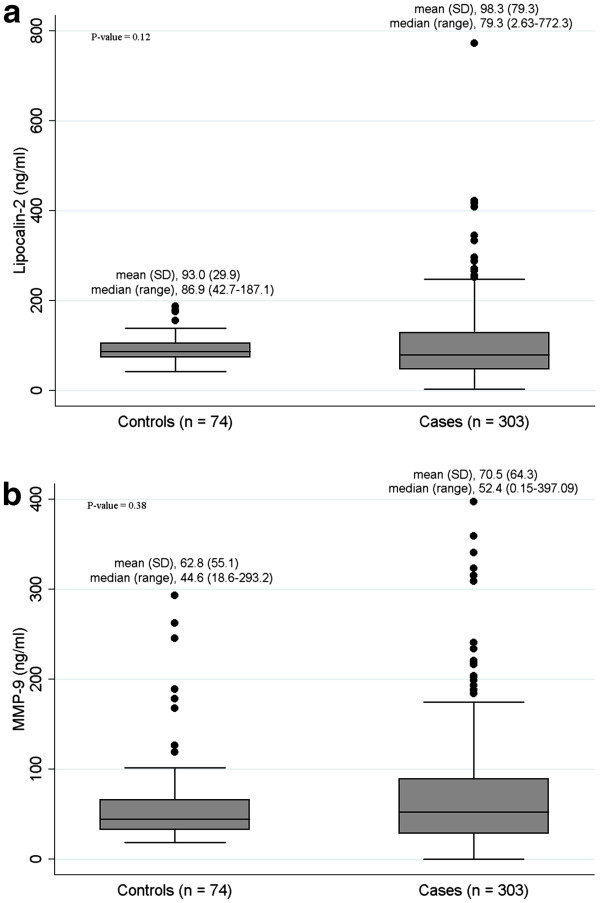
Serum levels of (a) lipocalin-2 and (b) MMP-9 depicted as box-plots. The levels of both markers were compared between breast cancer cases ( N = 303) and age and sex matched healthy controls ( N = 74). Lines inside boxes represent the median value and each box represents the interquartile range. Lines extend to minimum and maximum values excluding extreme values (circles). P-value was calculated from non-parametric Wilcoxon signed rank test.